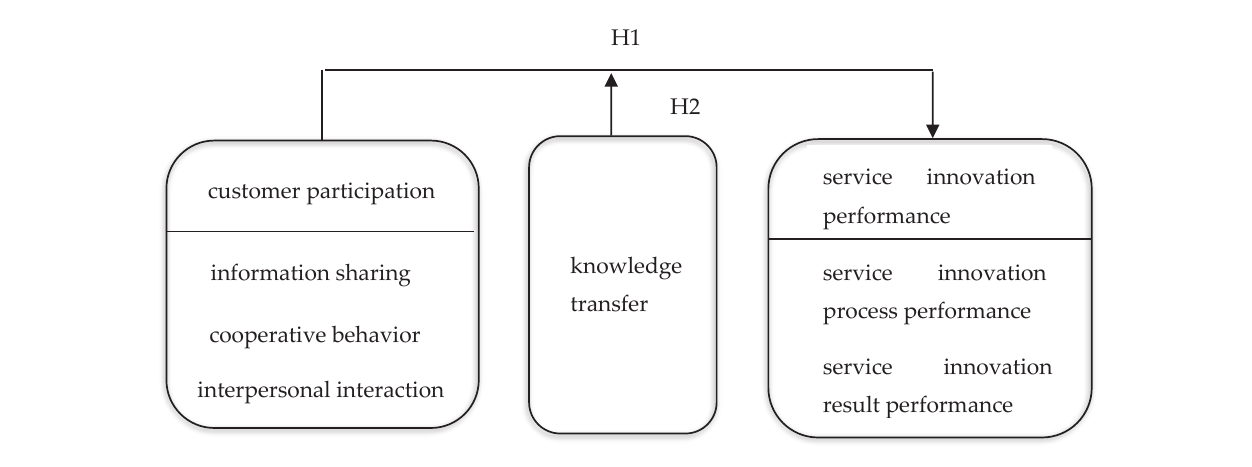
FIGURE 1 | Theoretical